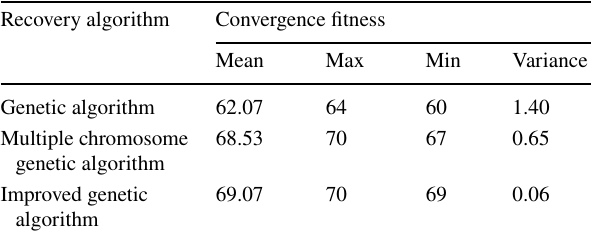
Table 6 Comparison of algorithm stability on quotient model Recovery